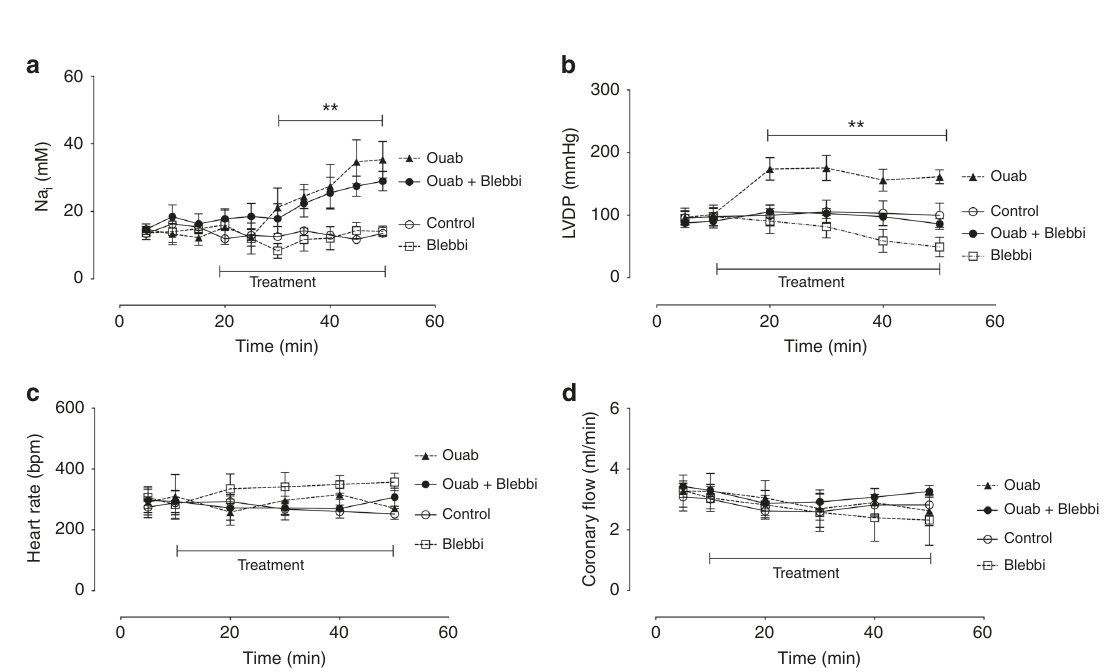
Fig. 3 Impact of acute 30 min Na/K ATPase inhibition on Na i and ex vivo function. a Time course of Na i elevation measured by 23 Na TQF fi ltered NMR. 40 min P < 0.01 vs baseline, 45 and 50 min P < 0.0001 vs baseline. b Impact on left ventricular developed pressure (LVDP) ** P < 0.01 versus baseline. c Heart rate (HR) and d coronary fl ow. Data are presented as mean ± SEM. Ouab = 75 μ mol/l ouabain ( n = 8); Ouab + Blebbi = 75 μ mol/l ouabain + 100 nmol/l blebbistatin ( n = 11); Control = KH buffer + vehicle (DMSO) ( n = 7); Blebbi = 100 nmol/l blebbistatin ( n = 5). P value is for the effect of the drug treatment by two-way ANOVA. Source data are provided as a Source Data fi